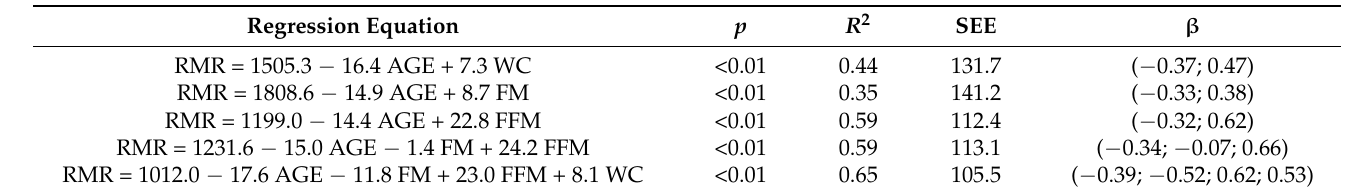
Table 2. Predictive equations used to estimate resting metabolic rate based on fat-free mass, fat mass, age, and waist circumference. Regression Equation